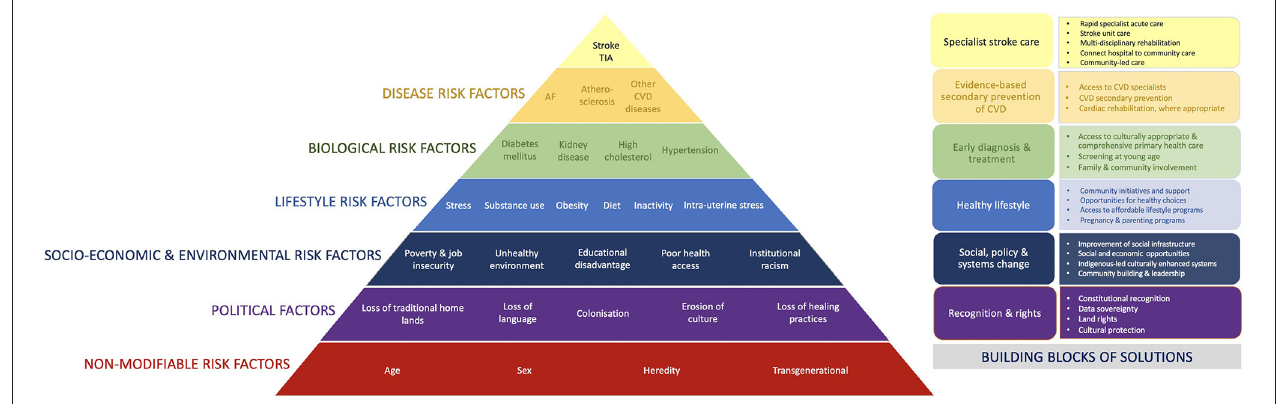
FIGURE 1 | Pyramid of stroke in Indigenous